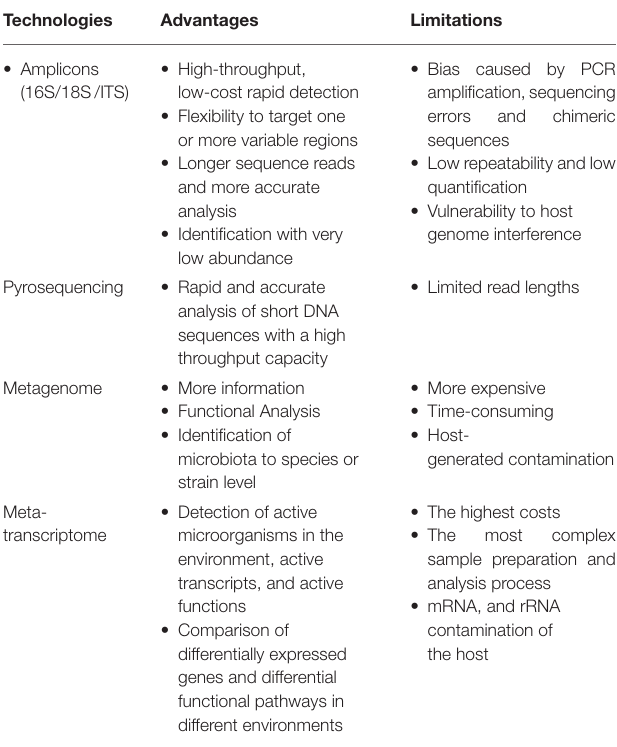
TABLE 3 | Advantages and limitations of major high-throughput